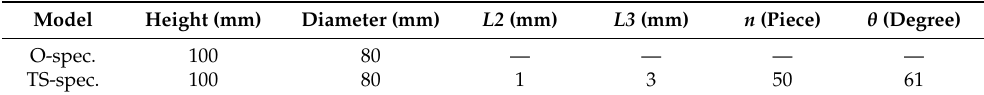
Table 6. Geometry parameters of the measurement